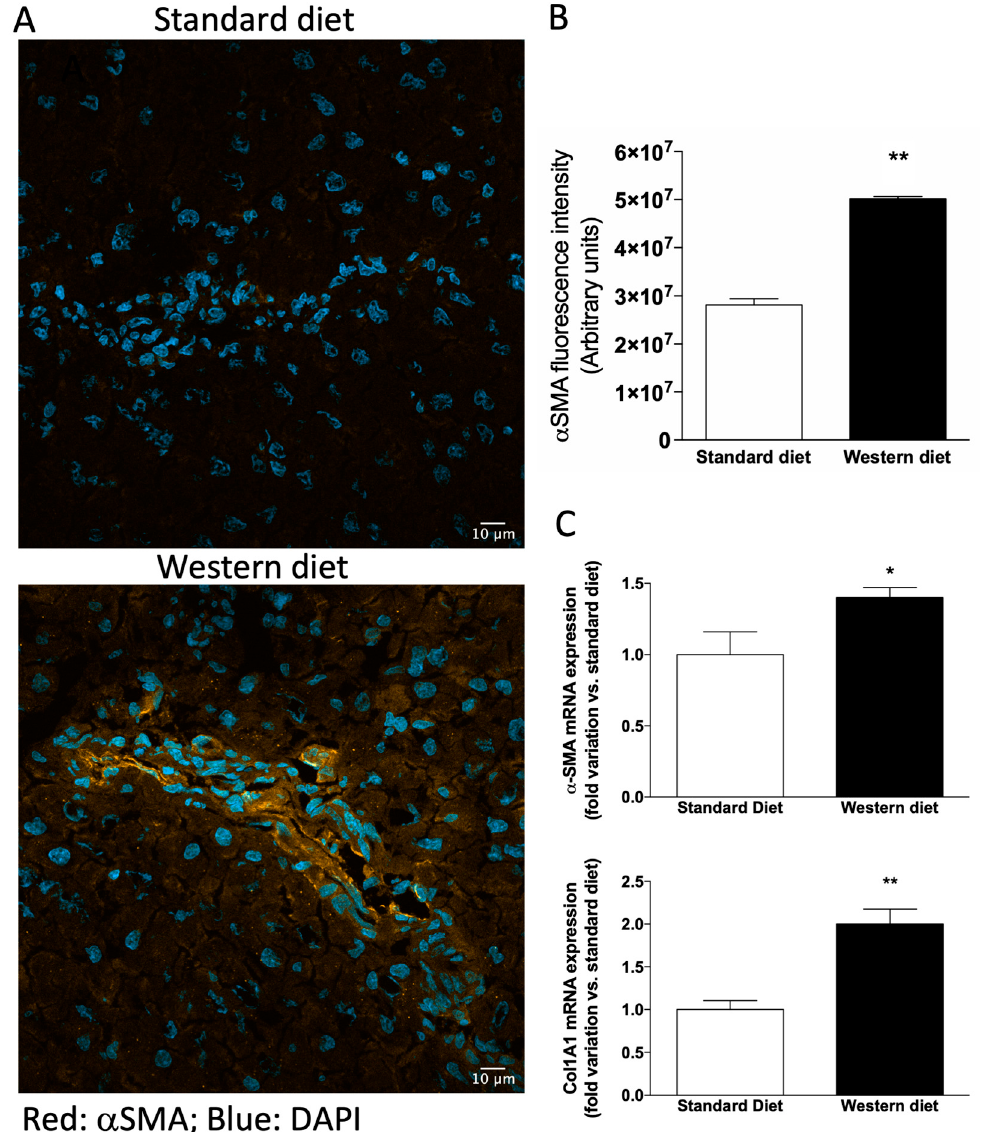
Figure 4. Activation of hepatic stellate cells. ( A ) Representative photomicrographs of liver tissue obtained from a rat fed with a standard (upper panel) and Western (lower panel) diet stained with α − SMA, a marker of hepatic stellate cells (HSCs) activation. ( B ) Quantification of α − SMA-related immunofluorescence. Values are reported as means ± S.E.M. Representative images from five independent experiments are shown. Cell nuclei are stained blue with DAPI. ( C ) mRNA expression of the fibrosis markers α − SMA and Col1A1. * p < 0.05 and ** p < 0.01 vs. rats fed with standard diet.